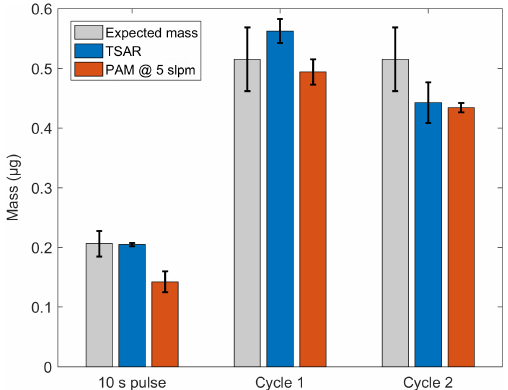
Figure 14. The expected and measured masses produced in pulse experiments. The expected mass is calculated from the mass of in- jected toluene and its SOA